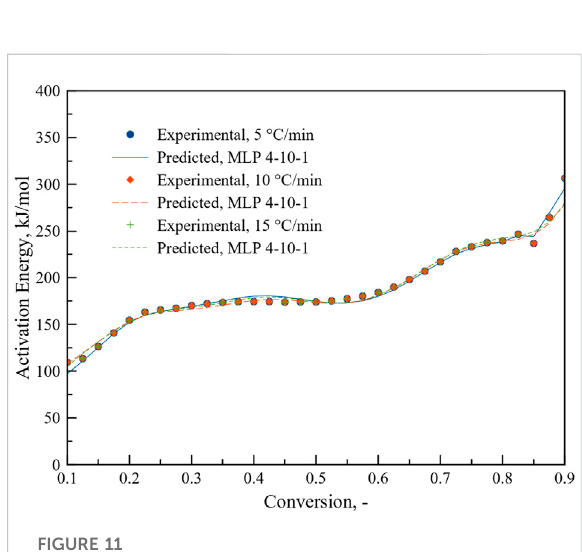
FIGURE 10 Regression plot of the ANN model output with the experimental target.